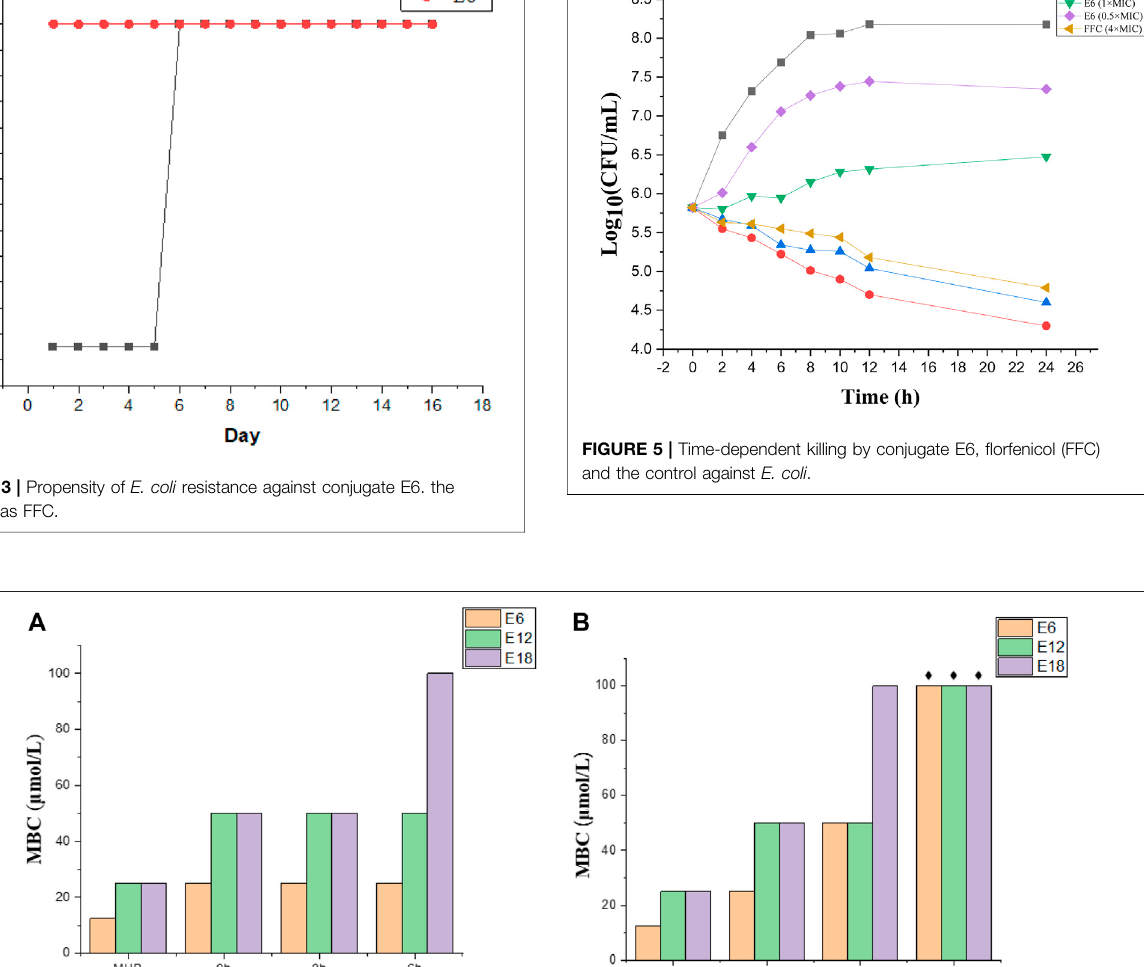
Frontiers in Chemistry |